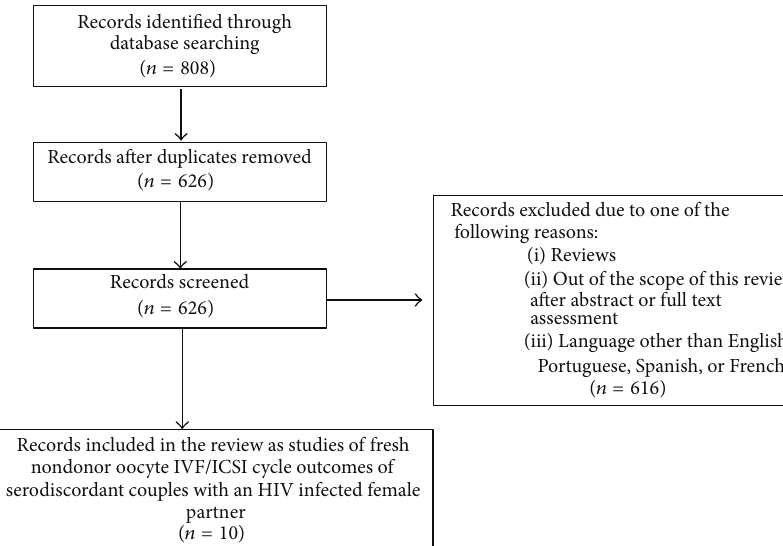
Figure 1: Flow chart for the search